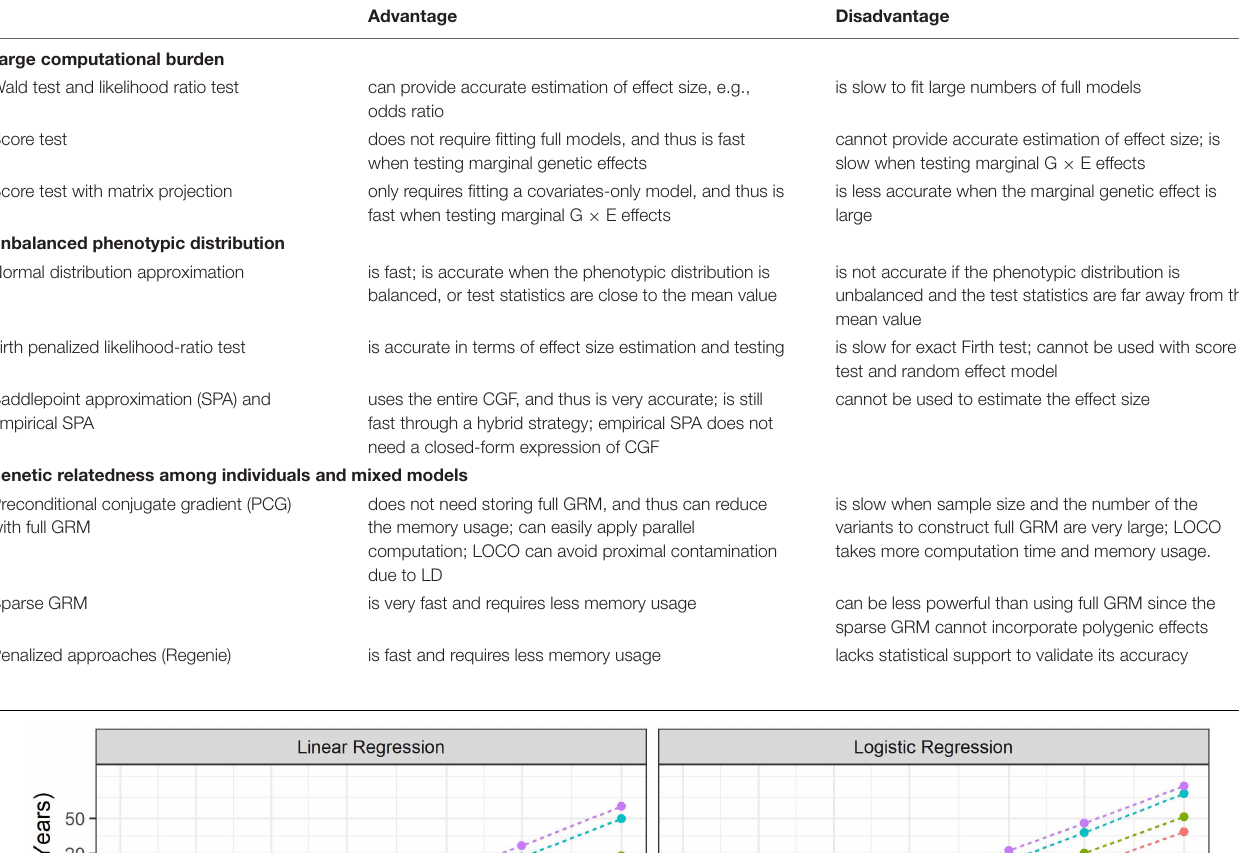
TABLE 1 | Statistical and computational techniques on large-scale biobank data analysis.